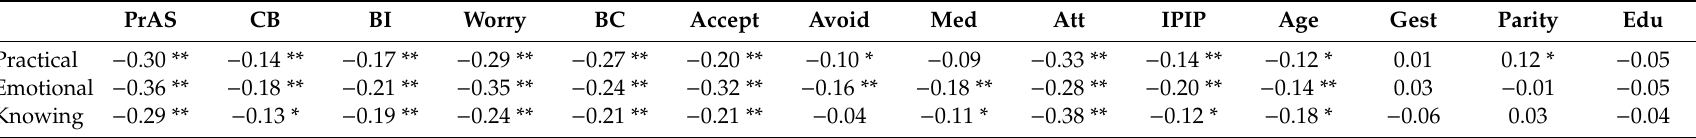
Table 6. Correlations between PrAS, IPIP and demographic variables and the PPES-R